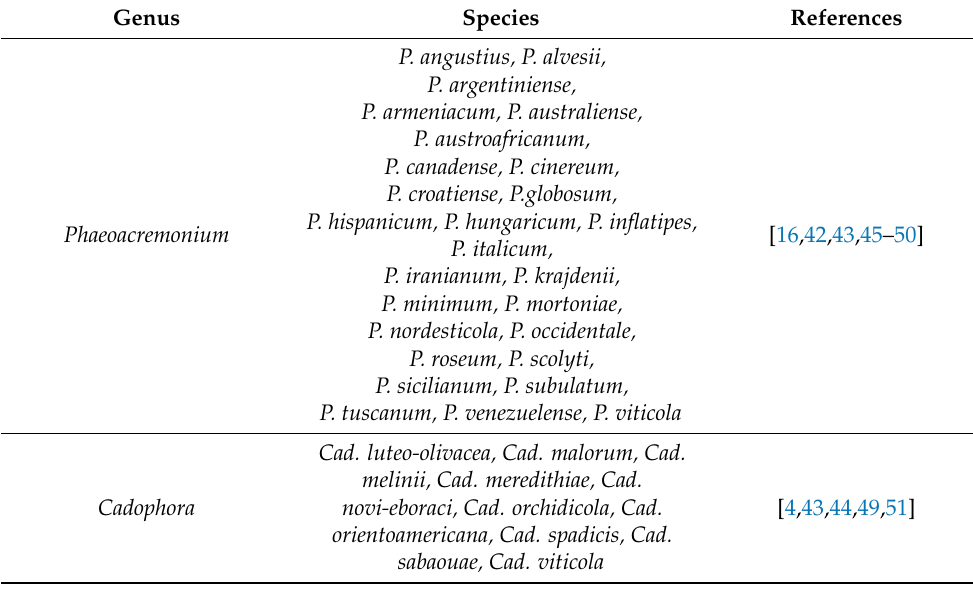
Table 1. Species of Phaeoacremonium and Cadophora involved in the Esca Complex.